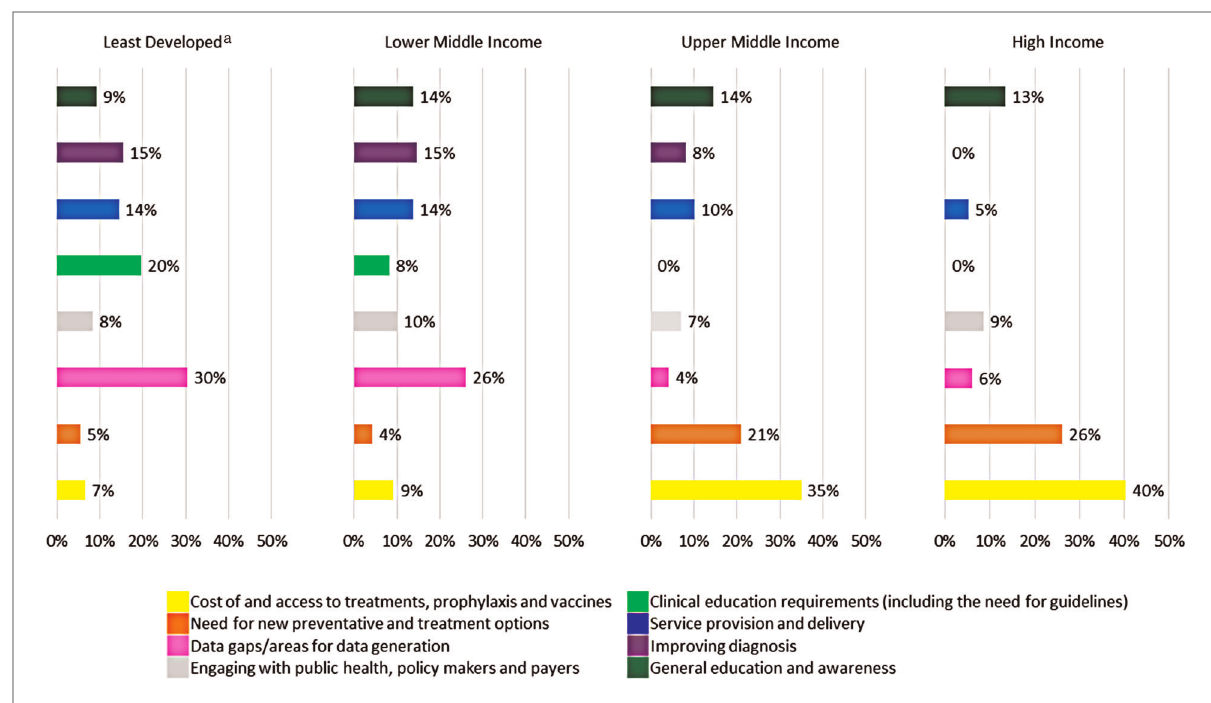
FIGURE 1 Most important areas related to the current and future management of respiratory syncytial virus categorised by economic group b . b Bars represent the relative contribution (loading) of each area/theme to explaining the variance in the principal component analysis for the top quintile of factors for each economic group. a Including low-income